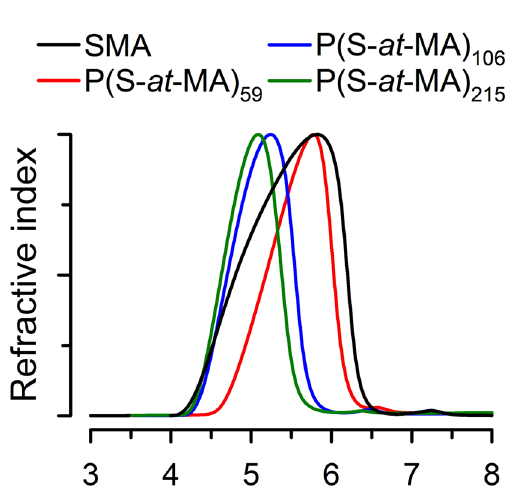
Figure 2. SEC of P(S- at -MA) alternating copolymers and SMA. SMA (Xiran), P(S- at -MA) 59 , P(S- at -MA) 106 and P(S- at -MA) 215 were run on an Agilent PLgel 5 µ m MIXED-D column equilibrated with DMF/0.02 M ammonium acetate, and run at 0.5 ml/min and 50 °C. Elution was monitored by following the refractive index. Each trace was normalized to its